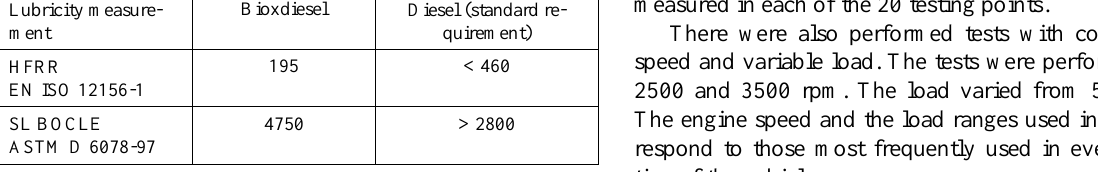
Table 5. Comparison of lubricity of tested biofuel and standard diesel Lubricity measure- ment